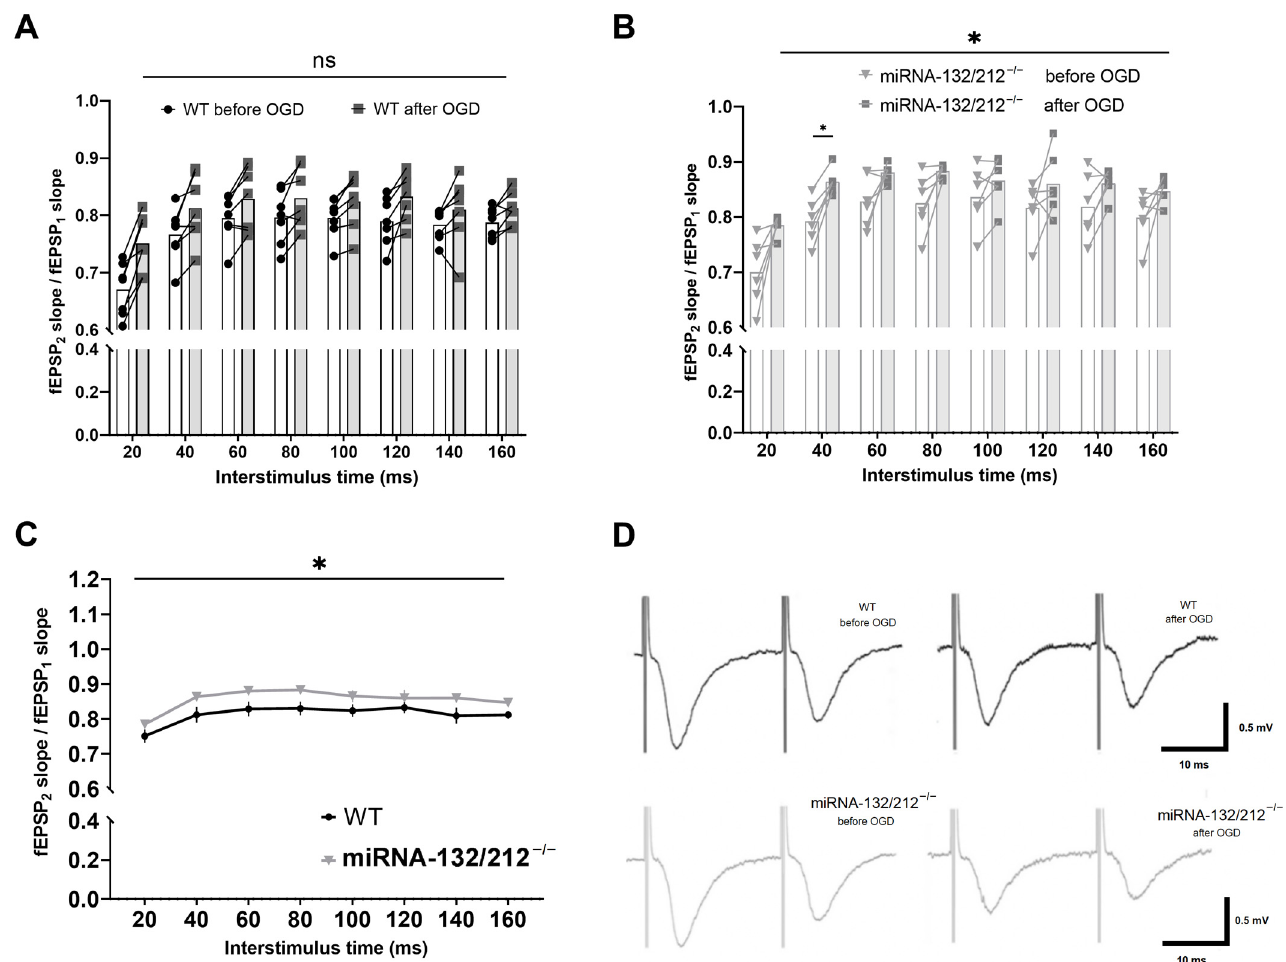
Figure 4. Repeated OGD impaired short term inhibitory plasticity in the absence of miRNA 132/212. Normalized and averaged PPI ratios (second pulse/first pulse) plotted against inter-pulse intervals from 20 to 160 ms, comparing responses from WT slices before and after the OGD treatment protocol: ( A ) PPI ratios, at ascending interstimulus intervals derived from WT slices and ( B ) miRNA-132/212 − / − slices before and after the OGD treatment protocol. ( C ) Comparison of PPI ratios, at ascending interstimulus intervals obtained from WT and miRNA-132/212 − / − slices after the OGD treatment. ( D ) Representative raw fEPSP traces obtained from WT (upper traces, black) and miRNA-132/212 − / − slices (lower traces, gray), before (left) and after (right) OGD treatment, applying a 20 ms inter-pulse interval paired pulse stimulation. Two-way repeated measures ANOVA revealed no statistically significant differences in the comparison of PPI ratios recorded in WT slices before and after OGD treatment ( A ). In contrast, PPI ratios increased significantly in miRNA-132/212 − / − slices after the OGD treatment, most pronounced at the 40 ms interstimulus interval (Bonferroni’s multiple comparisons tests) ( B ). Two-way repeated measures ANOVA revealed a significant difference between the genotypes after the OGD treatment ( C ). Data from n = 7 WT and n = 6 miRNA 132/212 − / − is presented as mean ± SEM. p < 0.05 was considered significant. * p < 0.05. ns: no statistical significance.